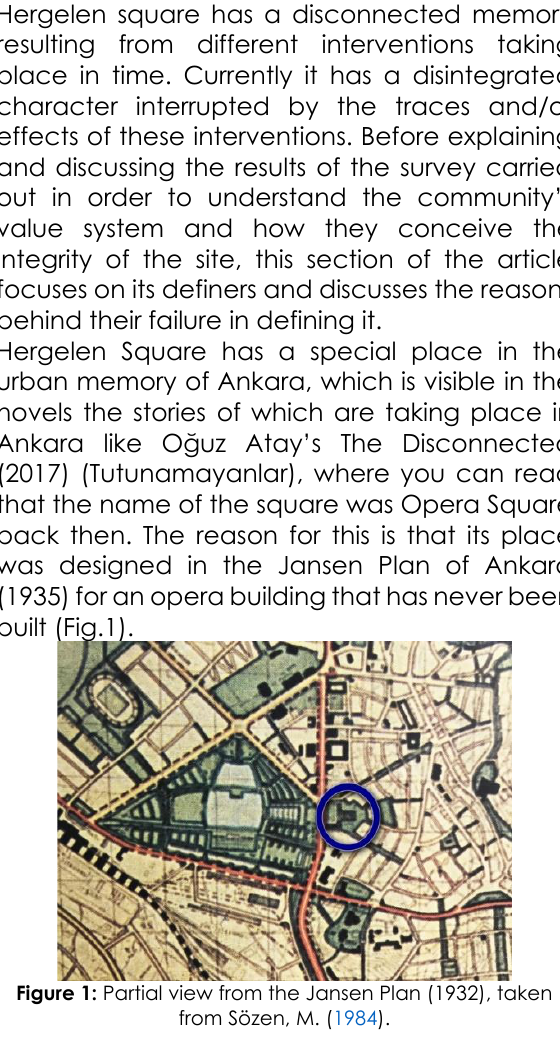
north end and presidents mansion on the south end. On that main axis, the eastern boundary